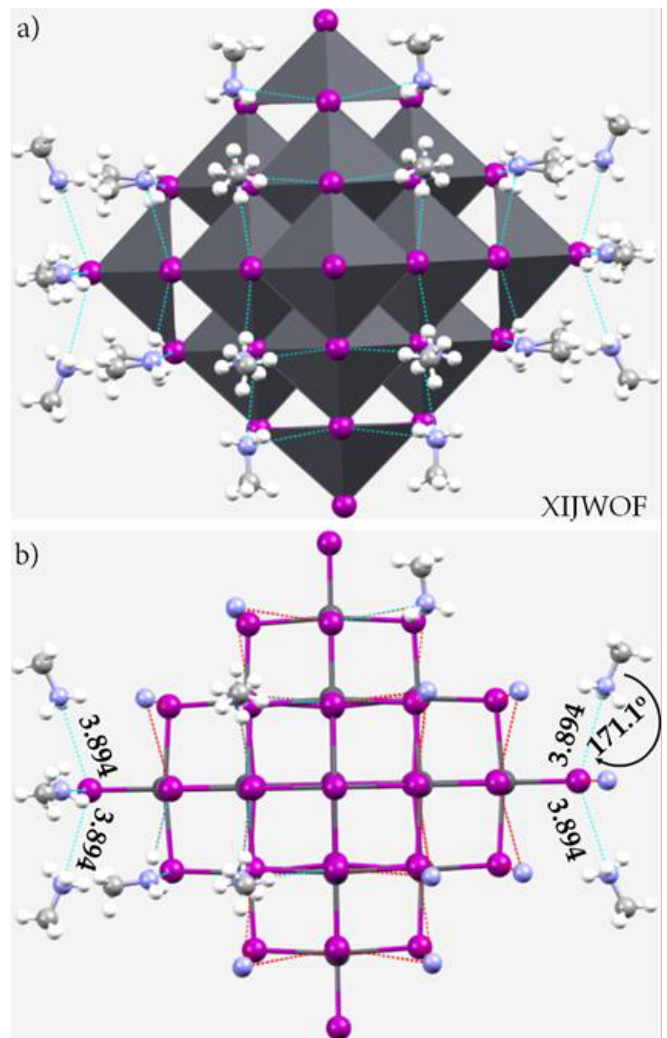
Figure 13. The spatial arrangement between the organic cations, [CH 3 NH 3 ] + , and inorganic frame- work, [I 44 Pb 18 ] 8 − , in the crystal structure of [I 44 Pb 18 ] 8 − [CH 3 NH 3 ] 8 , showing a number of quasi-linear N···I Type-IIa pnictogen bonds between the interacting units (dotted lines in red/cyan): ( a ) Polyhe- dral model and ( b ) ball-and-stick model of the inorganic framework. Selected bond lengths and bond angles are in Å and degrees, respectively.